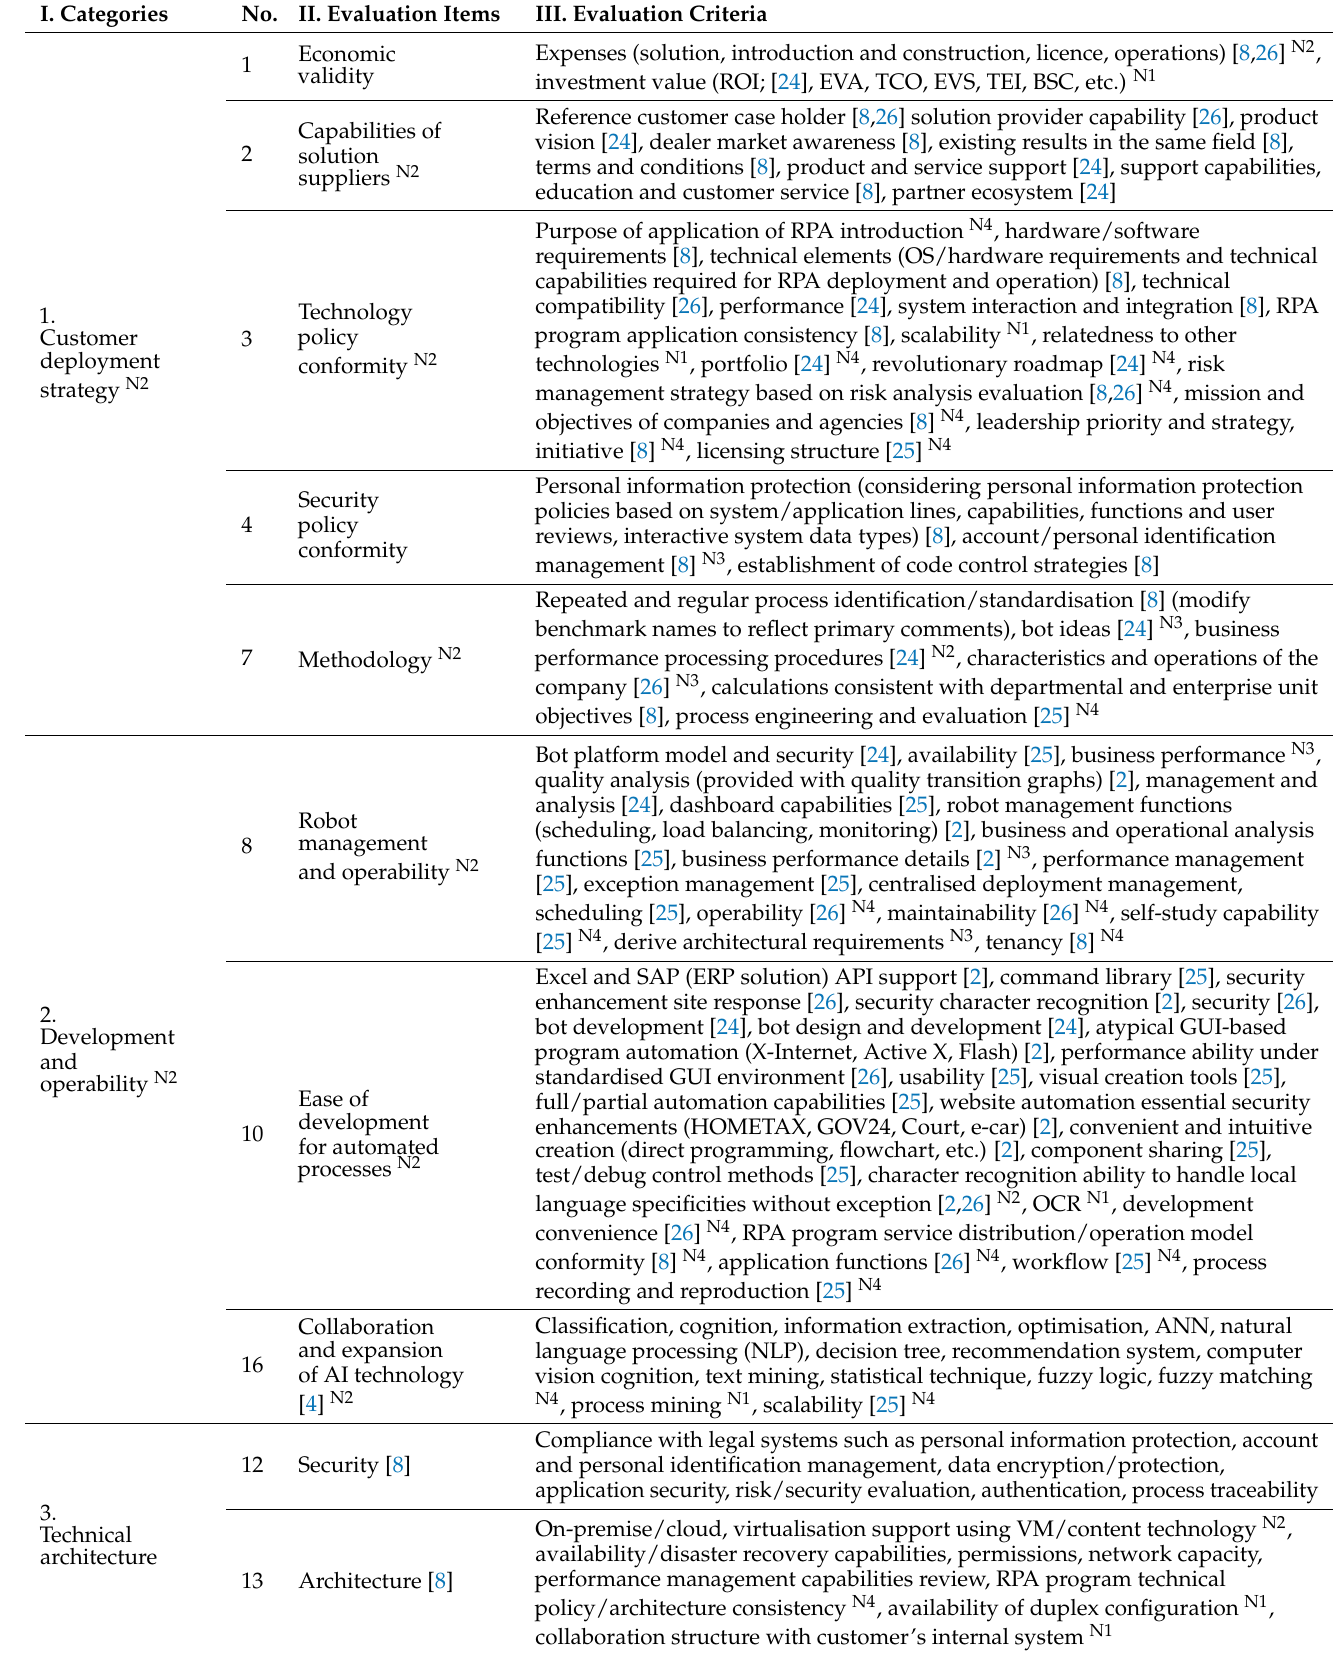
Table 7. Updated selection criteria based on the first round of Delphi evaluation